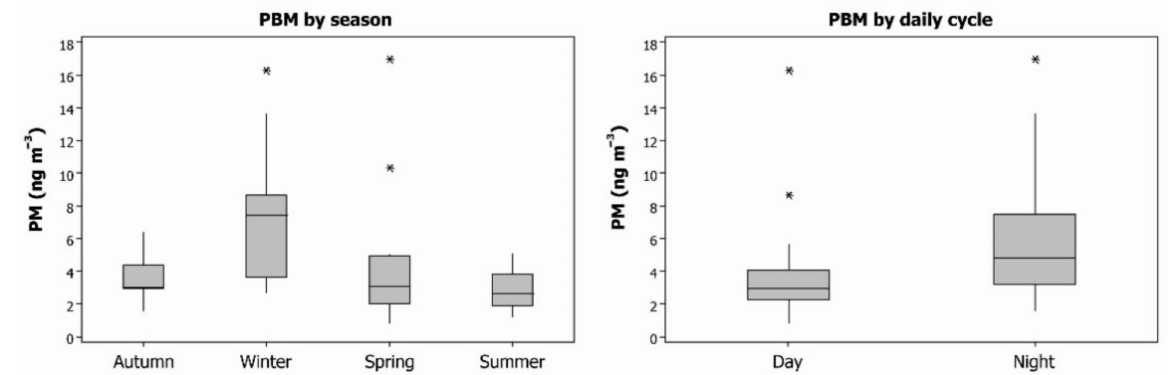
Figure 3. Boxplots of PBM concentrations in the Almad é n area by season and by day/night cycle. Outliers appear with the symbol (*).